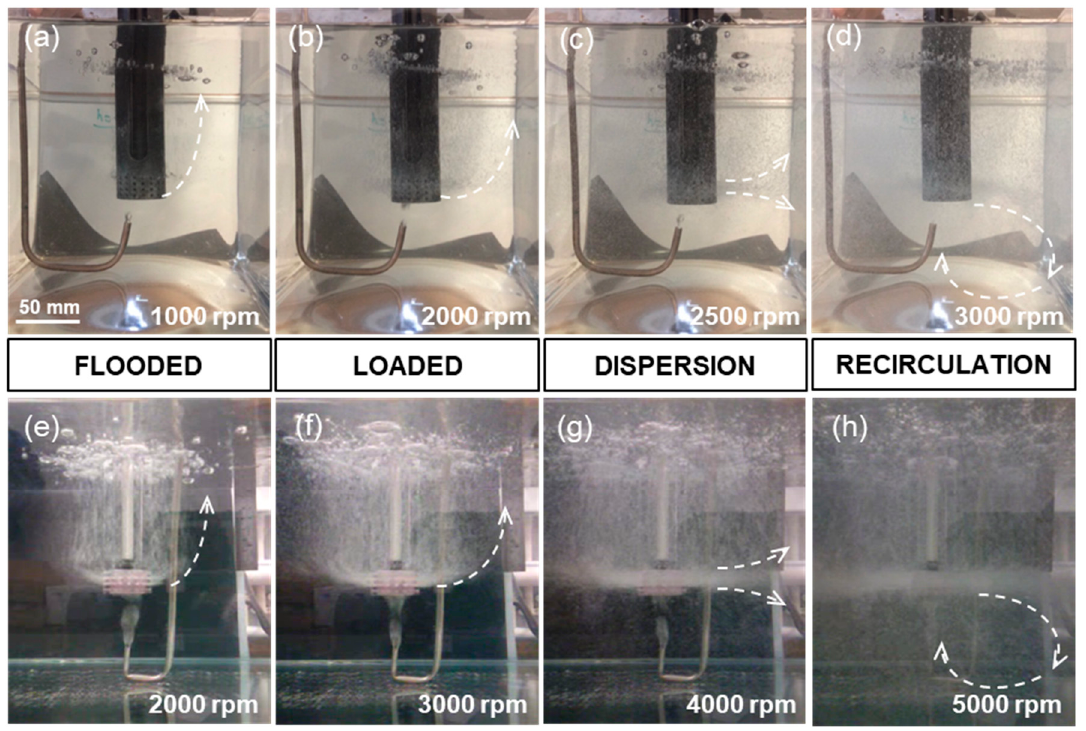
Figure 3. Visualization in water of the effect of gas flow rate and rotor speed on the bubble dispersion during HSMC degassing processing: ( a – d ) 0.1 L/min; ( e – h ) 1.0 L/min. The arrows indicate the flow pattern of the bubbles in the melt. Adapted from [24].